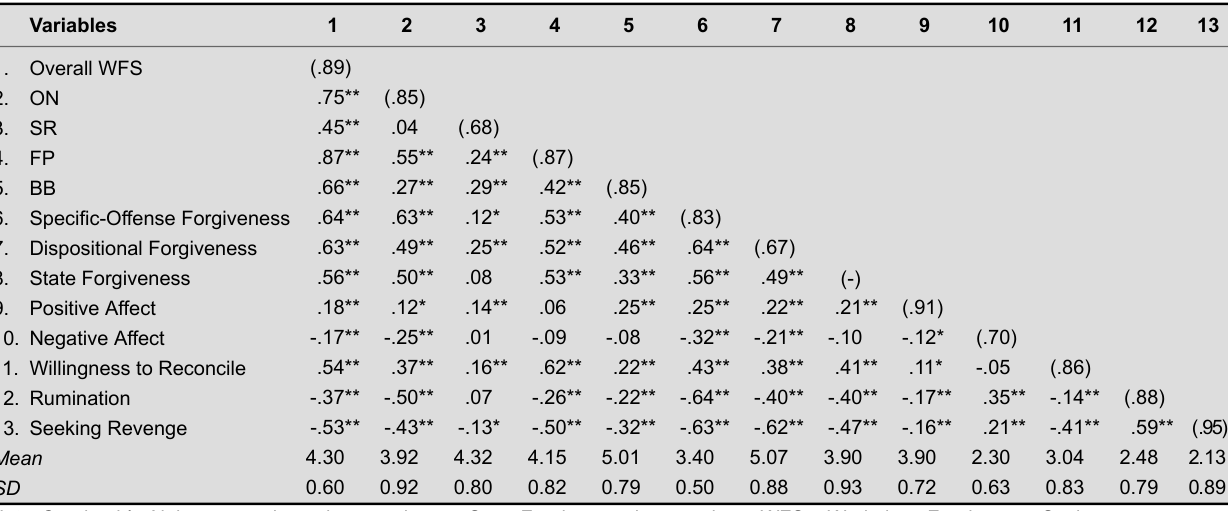
Correlation Coefficients, Reliability, Mean, and Standard Deviations of